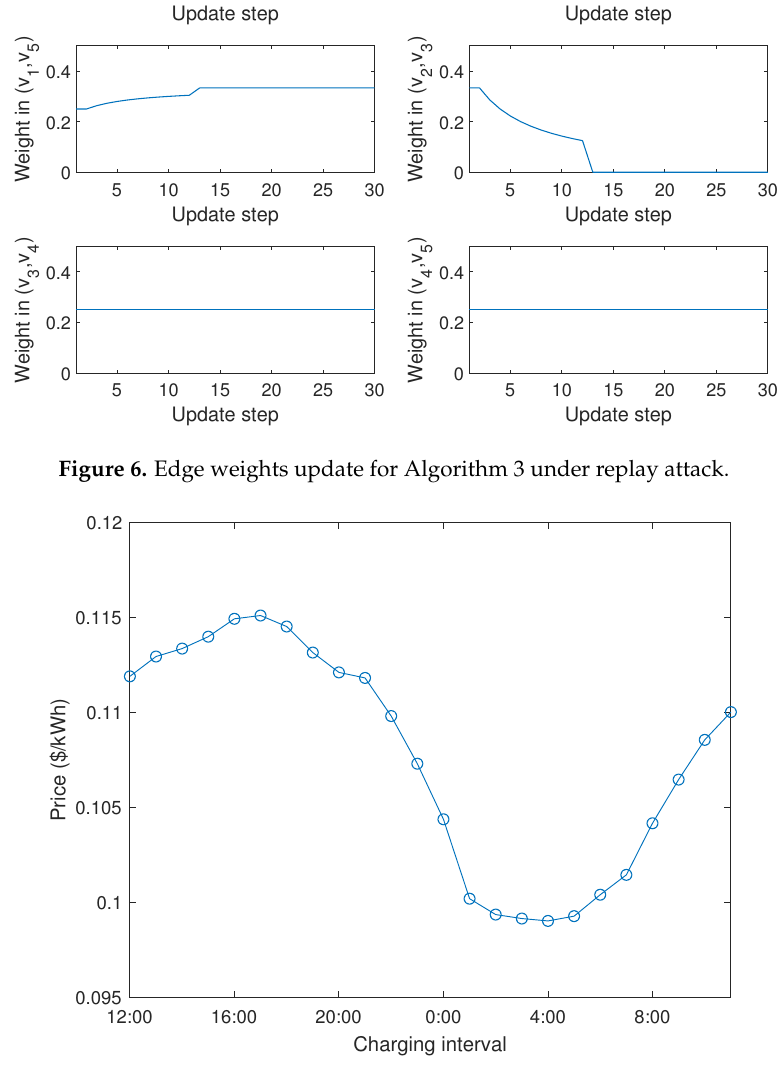
Figure 7. Common electricity price updates for Algorithm 3 under replay attack or random